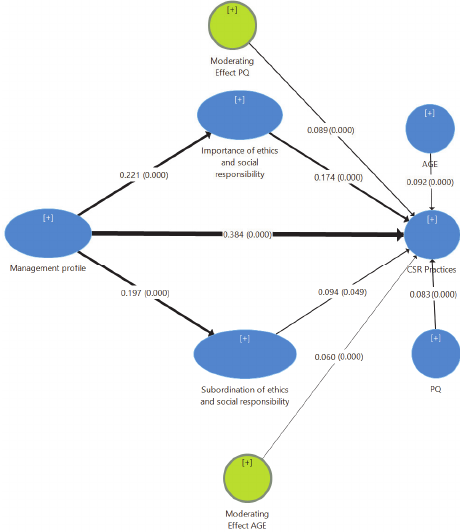
Fig. 4 . Test result on the moderate role of CEO’s age and professional